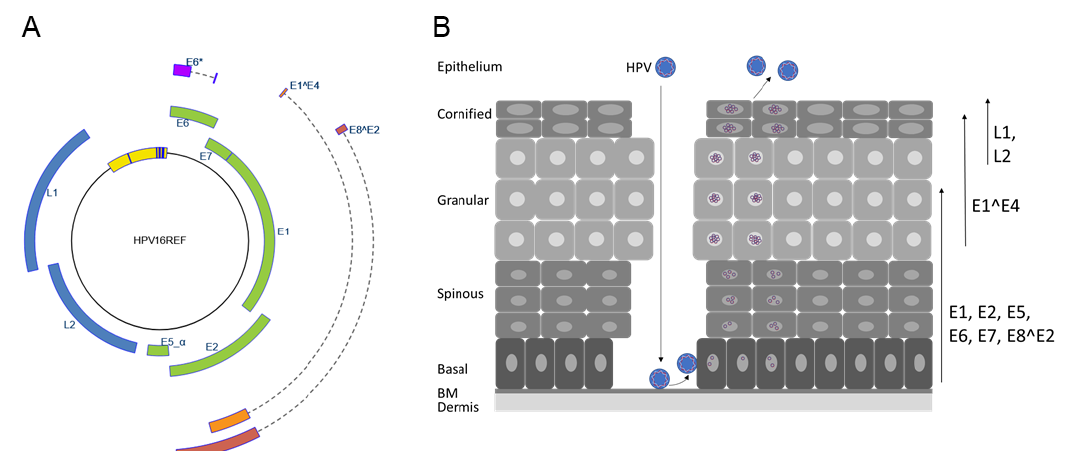
Figure 1. The HPV genome and life cycle. ( A ) The human papillomavirus 16 genome structure. Open reading frames E1 , E2 , E5 , E6 , E7 , L1, and L2 are indicated. Spliced mRNAs (indicated by dashed lines) are used to generate the E6*, E1^E4, and E8^E2 proteins. The upstream regulatory region, which is located between the L1 and E6 genes harboring the origin of replication and transcription control elements, is depicted in yellow, and blue bars indicate conserved E1 and E2 binding sites. The illustration was taken from https://pave.niaid.nih.gov/#explore/reference_genomes/human_genomes (accessed on 1 January 2020) [1]. ( B ) Schematic representation of the stratified epithelium and the HPV life cycle. HPV virions infect basal cells adjacent to the basal membrane (BM) via microlesions in the epithelial barrier. The viral life cycle is tied to differentiation and ends with the production of progeny virus that are released from terminally differentiated cells. Arrows on the right indicate differentiation-dependent expression of viral proteins. After introduction of viral genomes into undifferentiated keratinocytes, the viral E5, E6, and E7 oncoproteins as well as the replication modulatory E1, E2, and E8^E2 proteins are expressed. Expression of E1^E4 coincides with viral genome amplification in the spinous and granular layers. The expression of L1 and L2 in the terminally differentiated cells of the upper epithelium leads to the packaging of viral genomes, virion synthesis, and the release of virions.